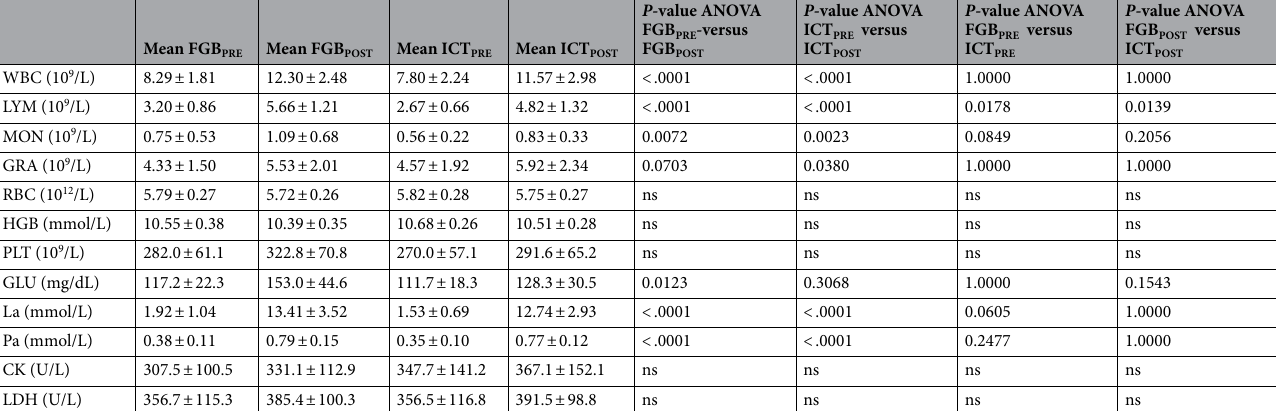
Table 8. Differences in hematological and biochemical parameters between Fight Gone Bad and incremental cycling test (means of three measurements T 1 –T 3 ). CK, creatine kinase; FGB POST , after Fight Gone Bad; FGB PRE , before Fight Gone Bad; GLU, glucose; GRA, granulocytes; HGB, hemoglobin; ICT POST , after incremental cycling test; ICT PRE , before incremental cycling test; La, lactate; LDH, lactate dehydrogenase; LYM, lymphocytes; MON, monocytes; Pa, pyruvate; PLT, platelets; RBC, red blood cells; WBC, white blood